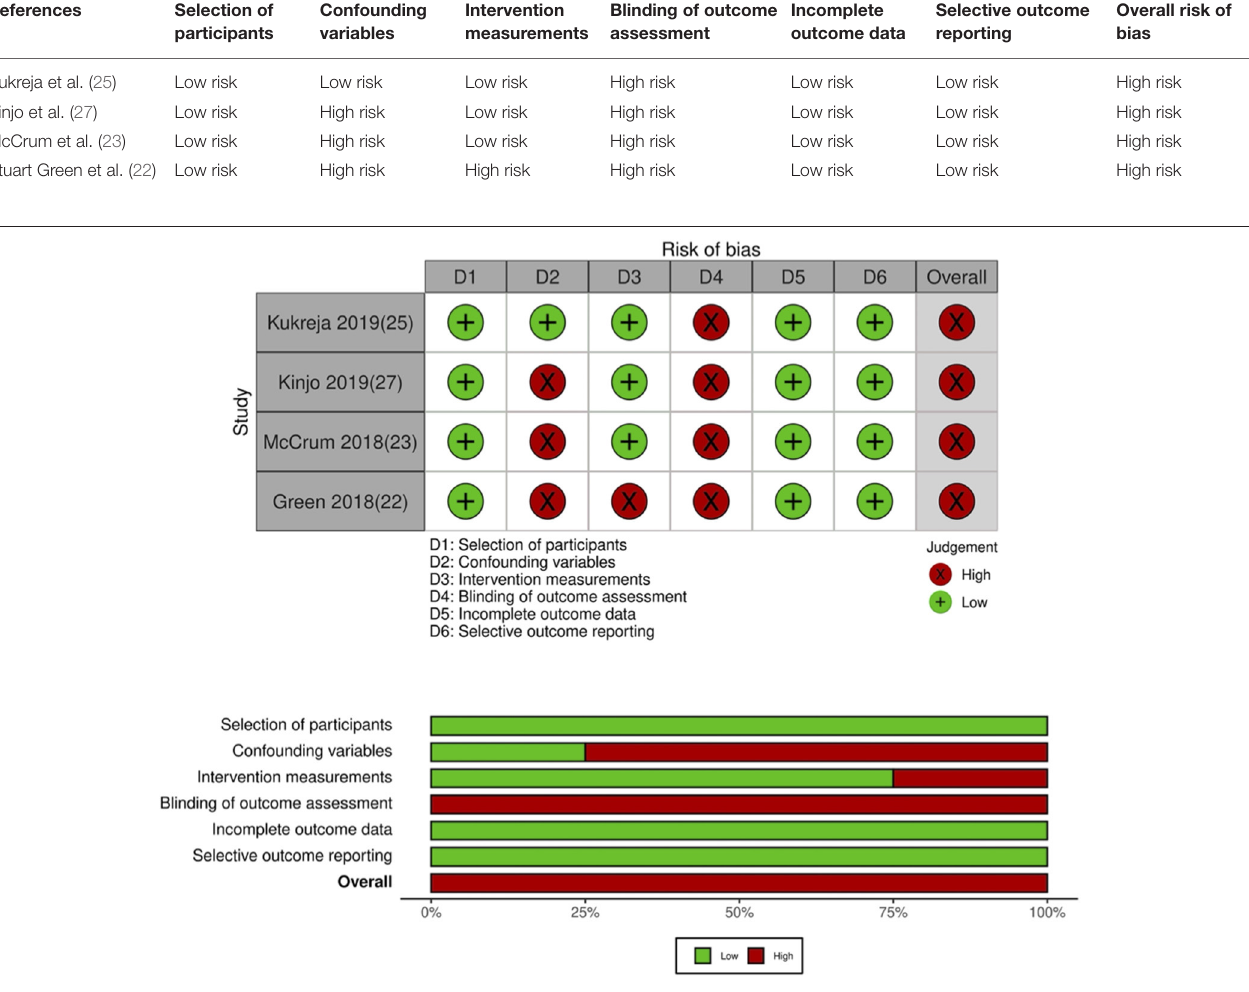
FIGURE 3 | Risk of bias plot for